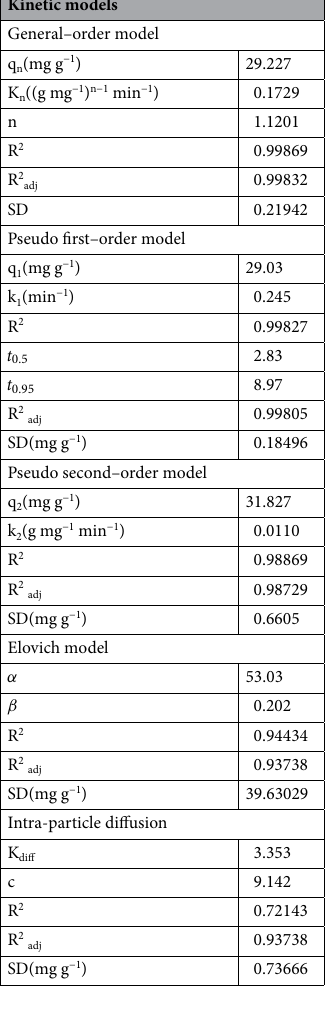
Table 1. Kinetics parameters of the adsorption of dye onto GO- Ziziphus